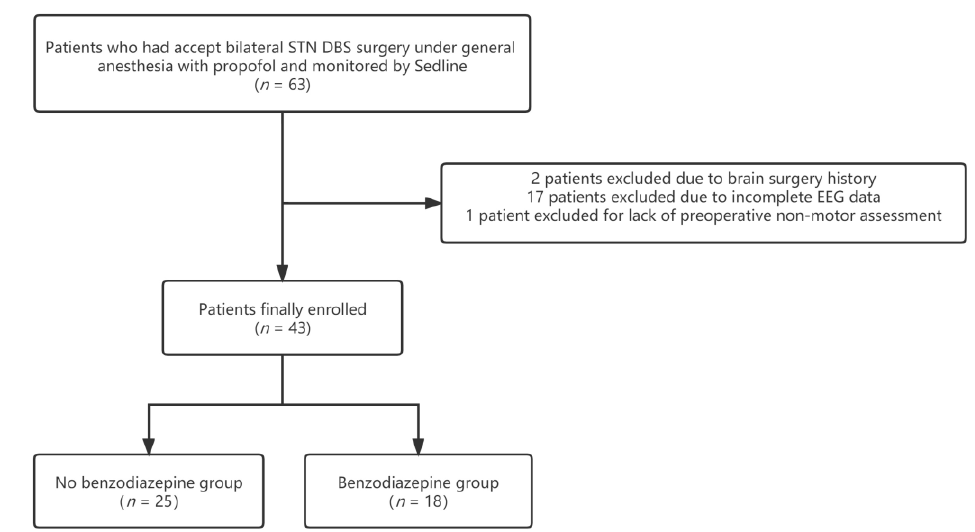
Figure 1. Flowchart detailing the selection of patients included in the retrospective analysis.